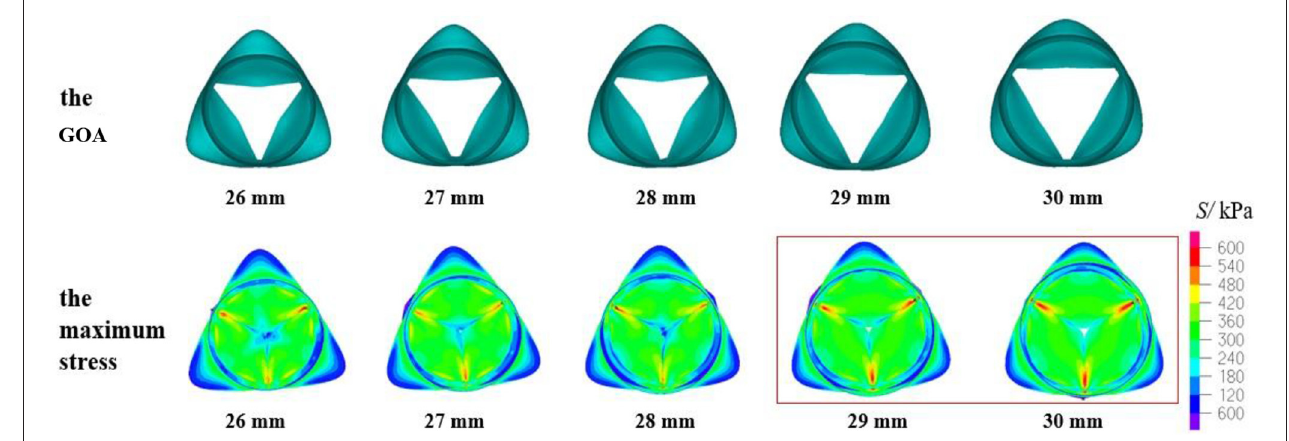
FIGURE 6 | Geometric orifice area (GOA) of the valve and maximum stress distribution of the model with valve height = 13.5mm and aortic annulus diameter of 26–30mm.